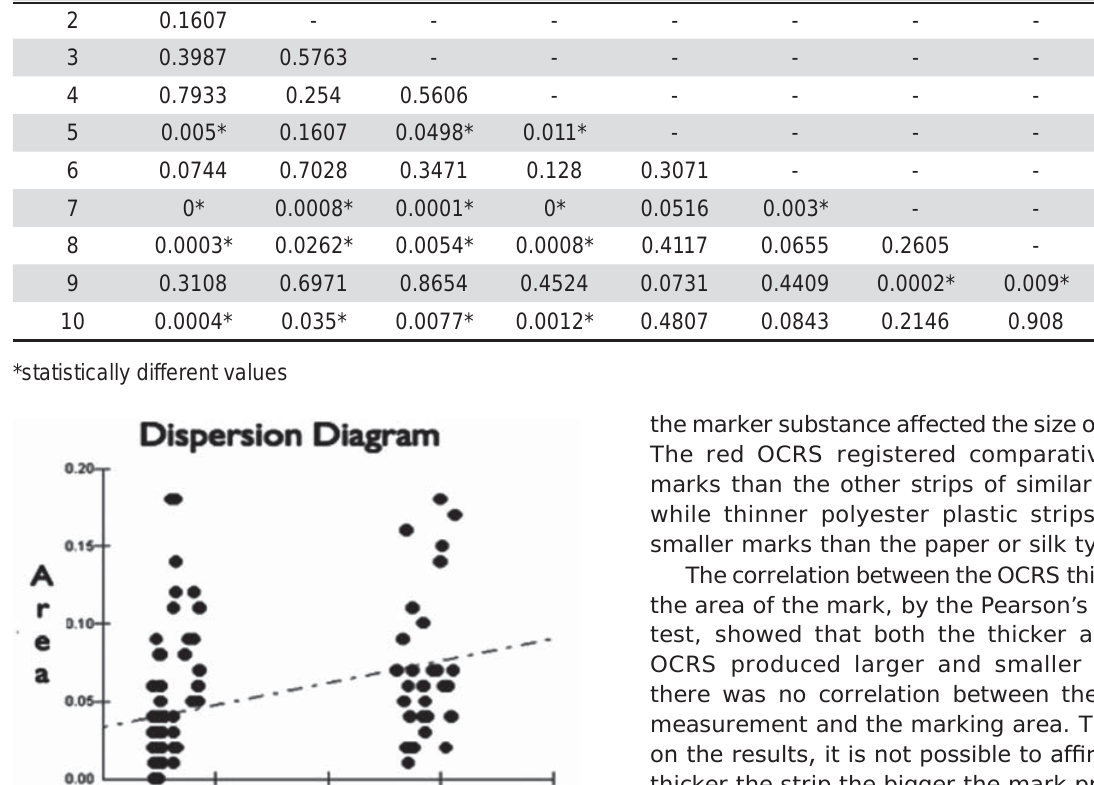
Table 2- (cid:3)(cid:50)(cid:70)(cid:70)(cid:79)(cid:88)(cid:86)(cid:68)(cid:79)(cid:3)(cid:70)(cid:82)(cid:81)(cid:87)(cid:68)(cid:70)(cid:87)(cid:3)(cid:85)(cid:72)(cid:74)(cid:76)(cid:86)(cid:87)(cid:85)(cid:68)(cid:87)(cid:76)(cid:82)(cid:81)(cid:3)(cid:86)(cid:87)(cid:85)(cid:76)(cid:83)(cid:86)(cid:3)(cid:11)(cid:50)(cid:38)(cid:53)(cid:54)(cid:12)(cid:3)(cid:87)(cid:75)(cid:76)(cid:70)(cid:78)(cid:81)(cid:72)(cid:86)(cid:86)(cid:3)(cid:179)(cid:83)(cid:180)(cid:3)(cid:89)(cid:68)(cid:79)(cid:88)(cid:72)(cid:86)(cid:3)(cid:11)(cid:86)(cid:76)(cid:74)(cid:81)(cid:76)(cid:191)(cid:70)(cid:68)(cid:81)(cid:70)(cid:72)(cid:3)(cid:79)(cid:72)(cid:89)(cid:72)(cid:79)(cid:12)(cid:3)(cid:16)(cid:3)(cid:80)(cid:68)(cid:85)(cid:78)(cid:76)(cid:81)(cid:74)(cid:3)(cid:68)(cid:85)(cid:72)(cid:68)